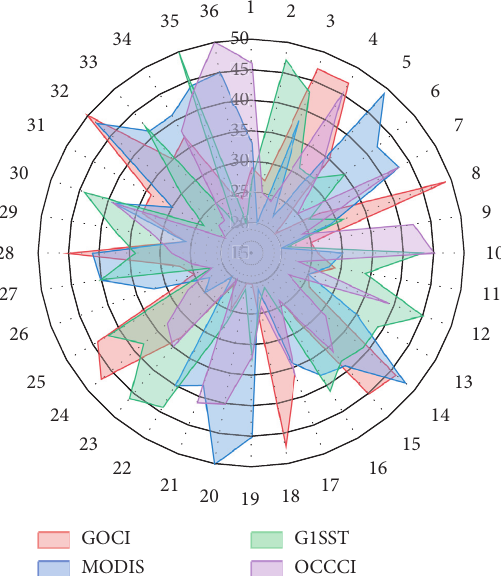
Figure 7: Variation of chlorophyll concentration at different